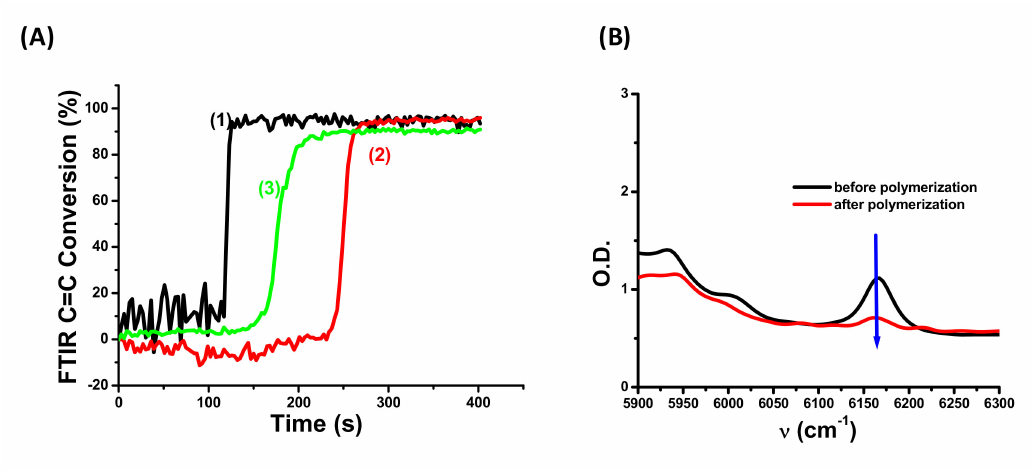
Figure 3. ( A ) Redox Polymerization profiles (methacrylate C = C function conversion vs. time; mixing for t = 0 s) measured in Real-time Fourier Transform Infrared (RT-FTIR) for the resin 1; 1.4 mm thick samples, under air for: (1) Mn(acac) 3 / DPS (1 / 1 %wt), (2) Mn(acac) 2 / DPS (1 / 1 %wt), (3) Cu(AAEMA) 2 / DPS (1 / 1